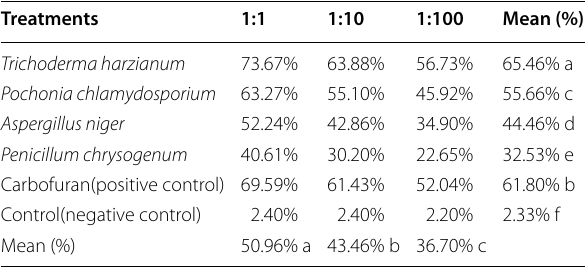
Table 3 Percentages of egg hatching inhibition by various fungal biocontrol agents at varying concentrations at 72 h Treatments